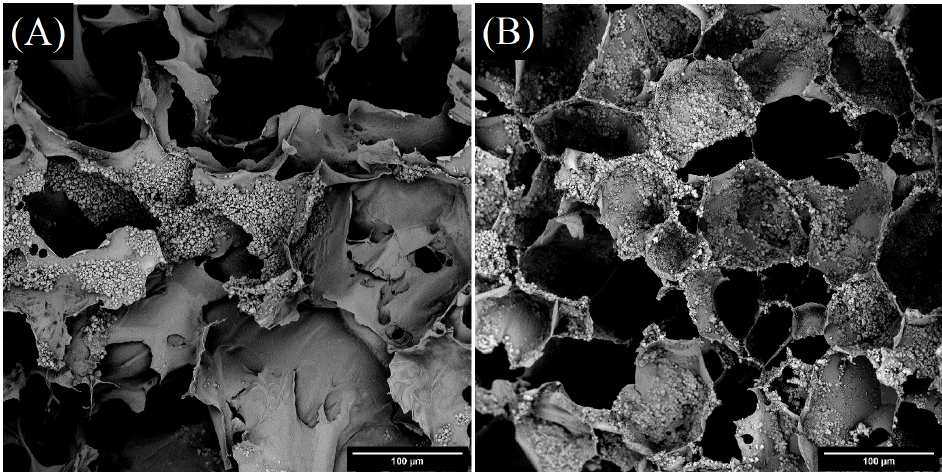
Figure 15. SEM micrographs of freeze-dried CIP-filled hydrogels: ( A ) gel E; ( B ) gel